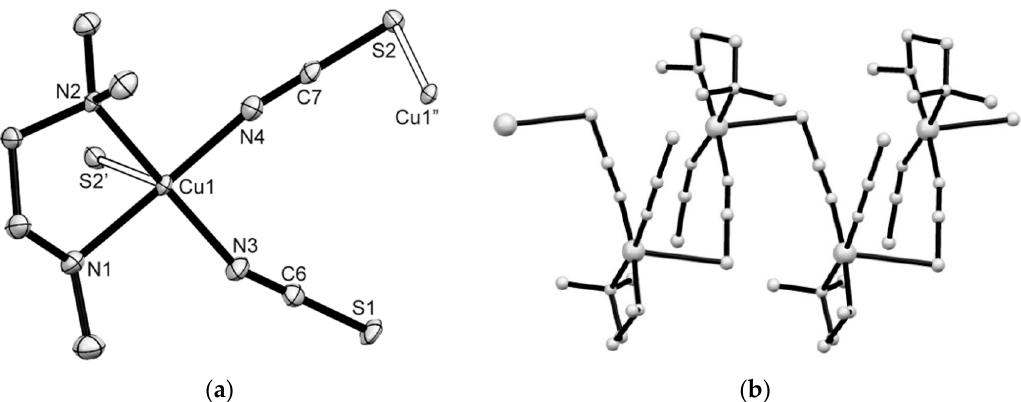
Figure 1. ( a ) Perspective view of the asymmetric unit and the Cu(II) coordination core of 1 (50% probability ellipsoids, only the major disorder form given for clarity). Symmetry codes: (‘) 3/2 − x,1 − y,1/2 + z; (“) 3/2 − x,1 − y, − 1/2+z. Selected bond distances (Å) and angles (°): Cu(1)-N(4) 1.952(4), Cu(1)-N(3) 1.966(4), Cu(1)-N(1) 2.024(4), Cu(1)-N(2) 2.066(3), Cu(1)-S(2’) 2.8910(16);